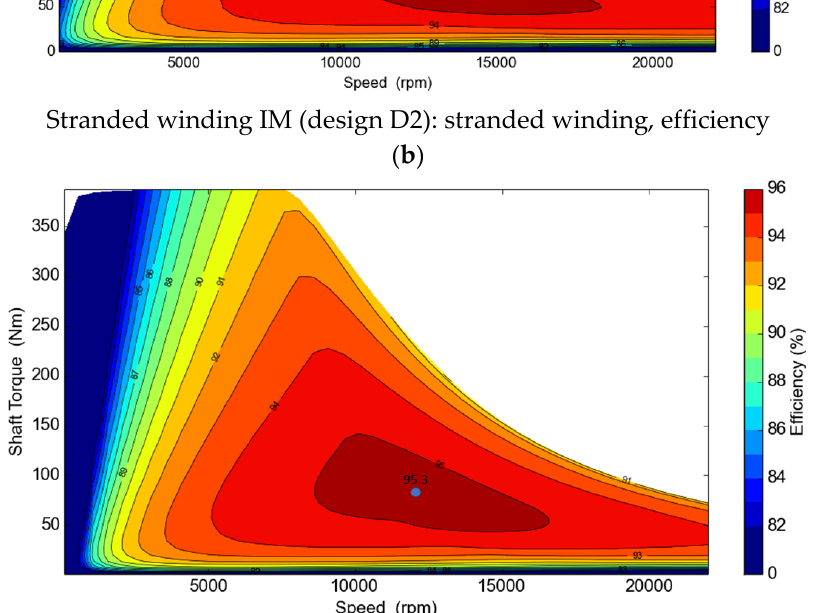
Figure 8. Efficiency maps for the three designs.